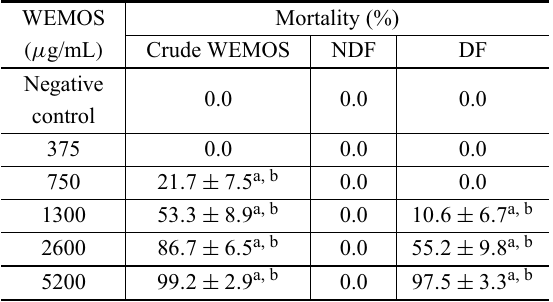
Larvicidal activity of the water extract of Moringa oleifera seeds (WEMOS) upon Aedes aegypti larvae after 24 h of exposure. Distilled water was used as negative